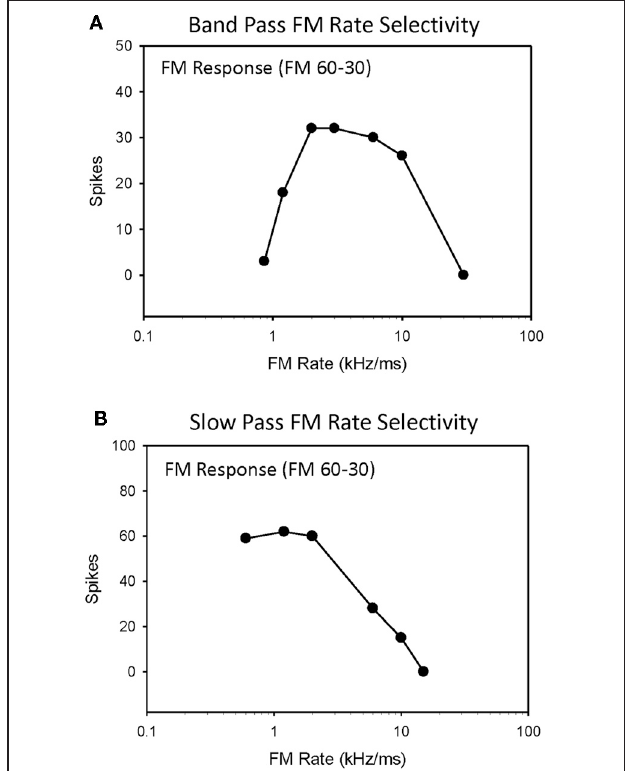
FIGURE 1 | Single-unit responses from the high-frequency region of the pallid bat IC were recorded for downward FM sweep rates ranging from 0.3 to 300kHz/ms and classified as either bandpass (A) or slowpass (B).